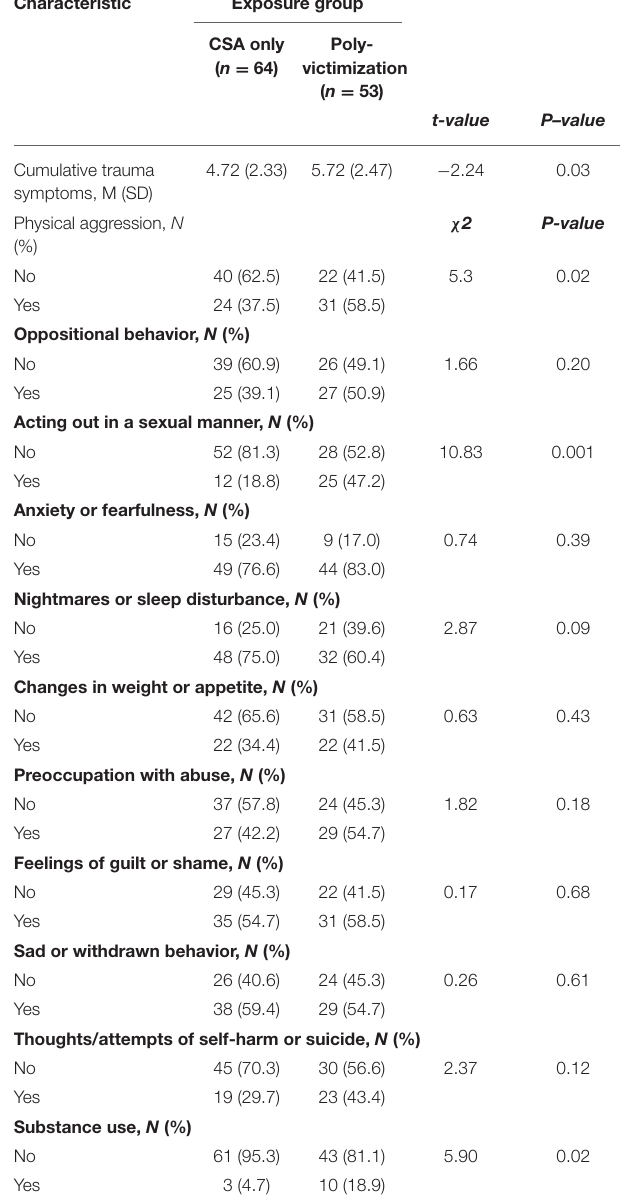
TABLE 5 | Differences in trauma symptoms among children exposed to CSA only vs. those who were poly-victimized. Characteristic Exposure